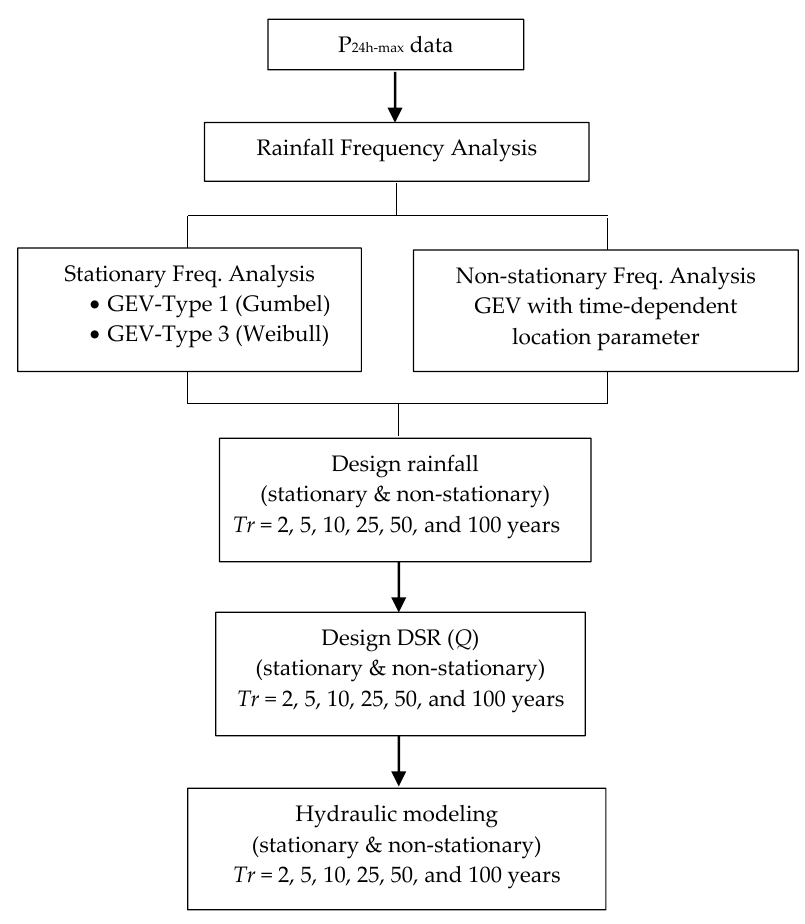
Figure 4. Proposed methodology flowchart.